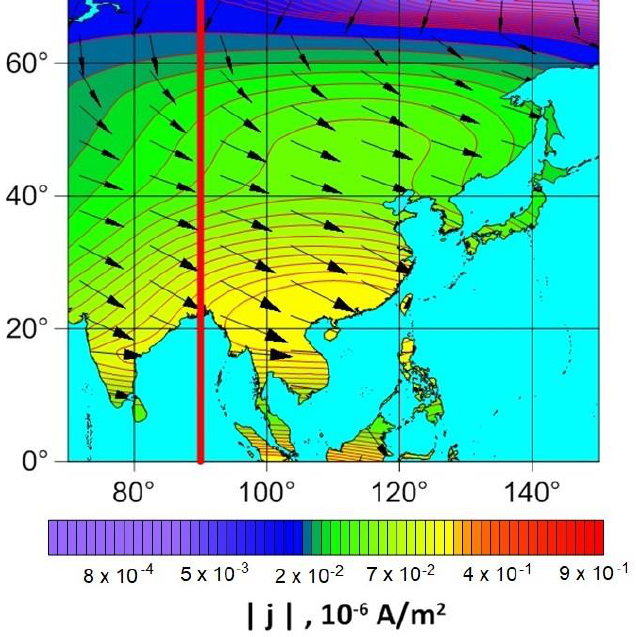
Figure 16. Spatial distribution of the amplitude of the electric current density module and the direction of its vector in the region limited by the coordinates 0–70 ◦ N, 70–150 ◦ E at the time t = 25 s. The red vertical line shows the position of the subsolar meridian.